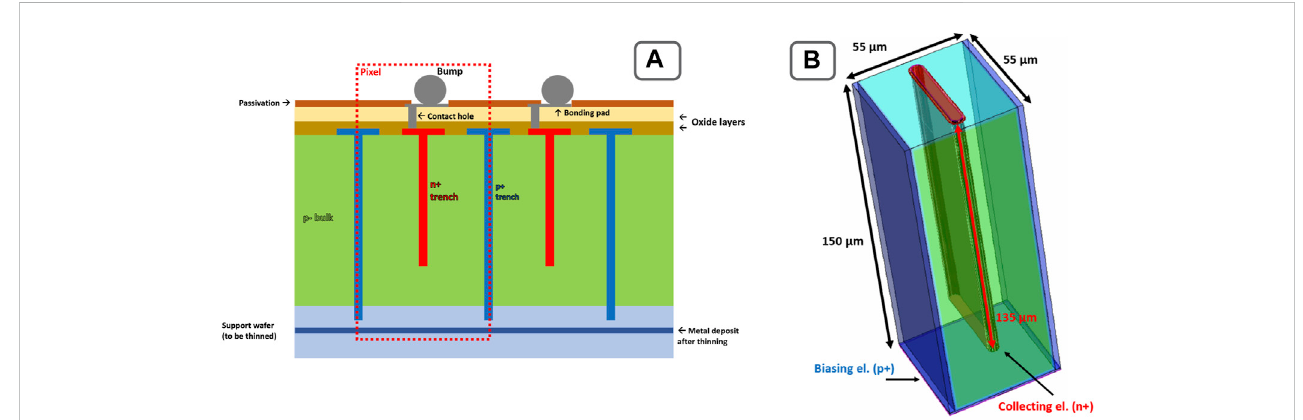
FIGURE 1 Geometry of a 3D trench-type silicon pixel. (A) Structure of a sensor and its doping pro fi les (red for n+ doping, green for p − doping and blue for p+ doping). (B) TimeSPOT pixel rendering with physical dimensions.